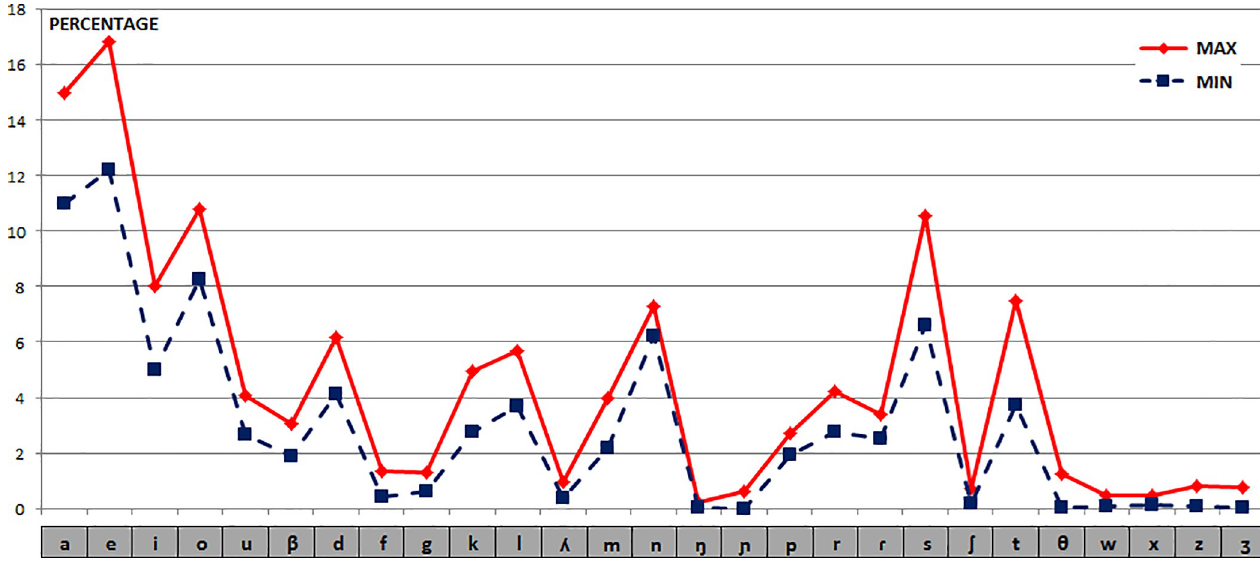
Fig 11. Frequency values of the phonetic units of the 10 Spanish or Castilian texts.